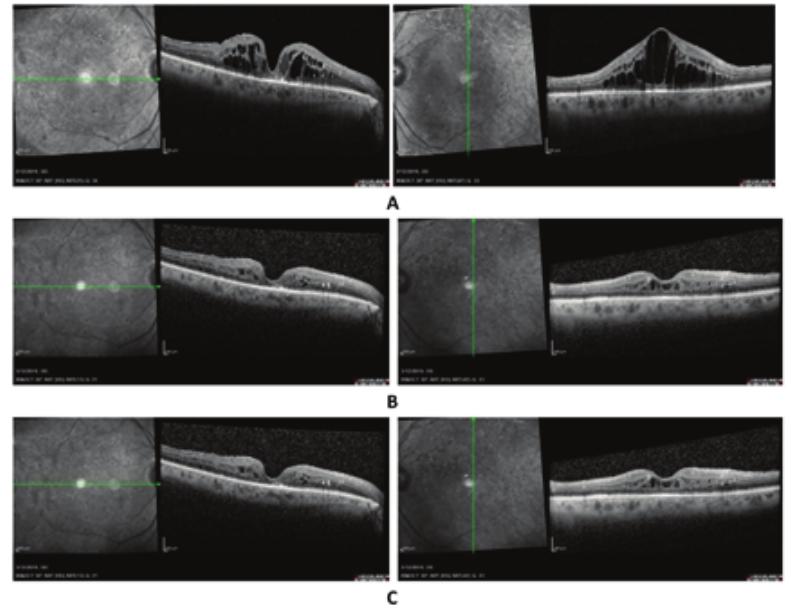
Figure 2. (A) Demonstrates the optical coherence tomography (OCT) before initiating the topical interferon alpha 2b treatment. The upper left and upper right are the horizontal raster of the right eye and vertical raster of the left eye, respectively, following the center of the fovea. (B) and (C) show the OCT at one- and three-month follow-up visits. In this case, tapering of the drop was started at eight